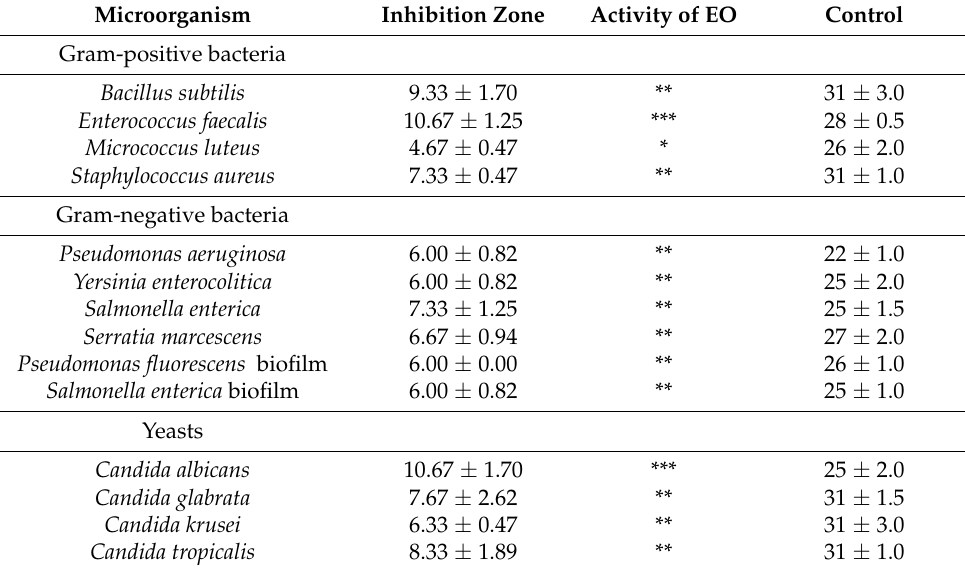
Table 2. Antimicrobial activity of TTEO.